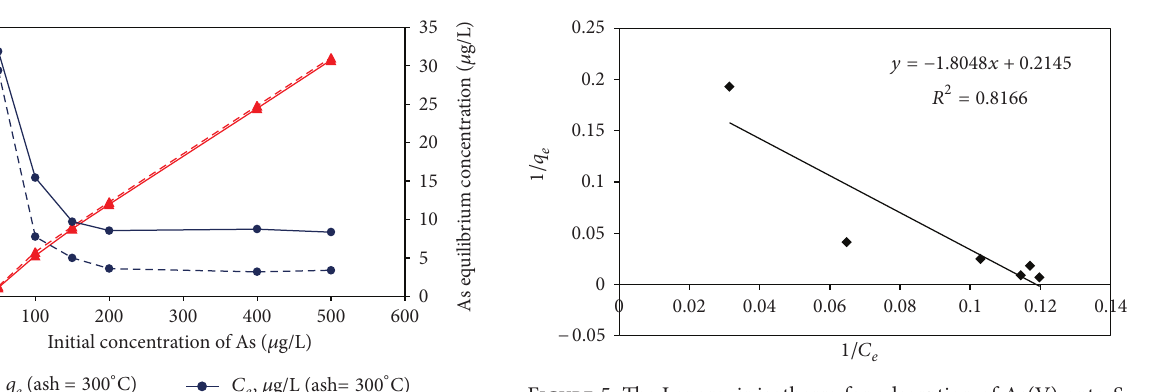
F 5: e Langmuir isotherm for adsorption of As(V) onto S. persica stem ash